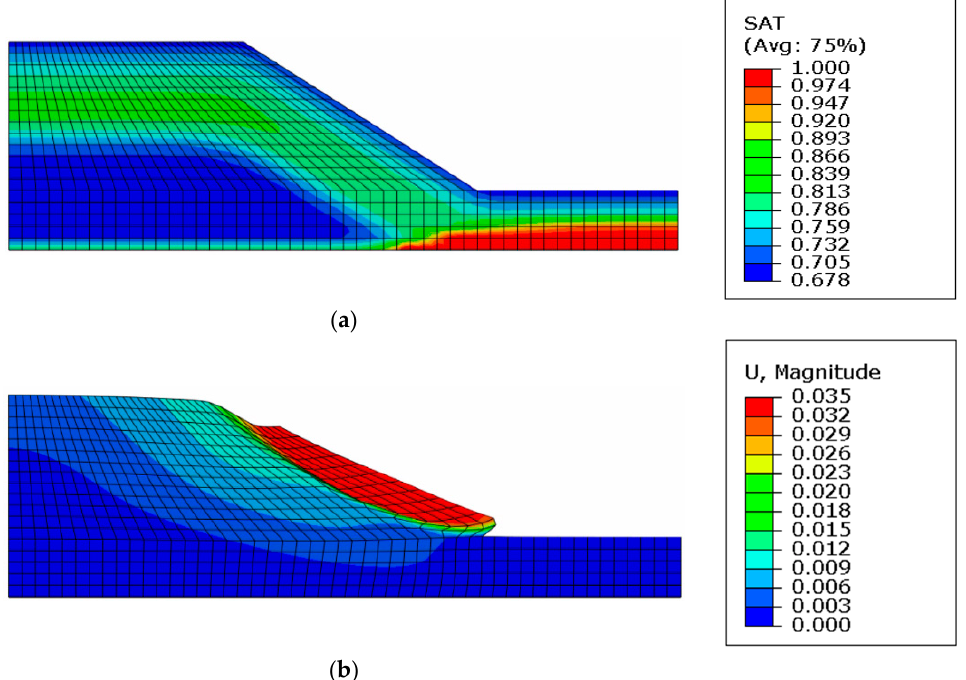
Figure 8. The FE infiltration analysis with a finer mesh size: ( a ) saturation distribution; ( b ) displace-